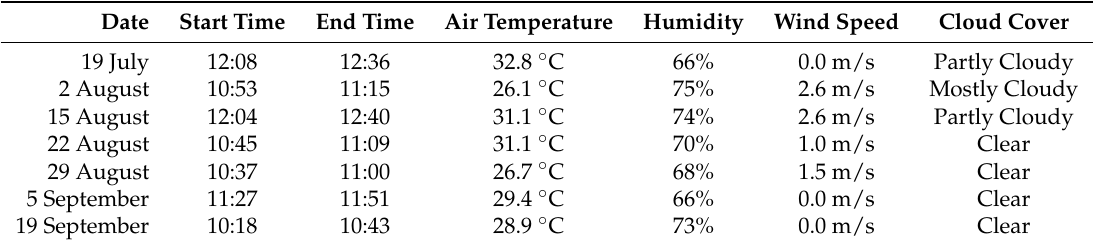
Table 3. Air temperature, humidity, wind speed, and cloud cover for each